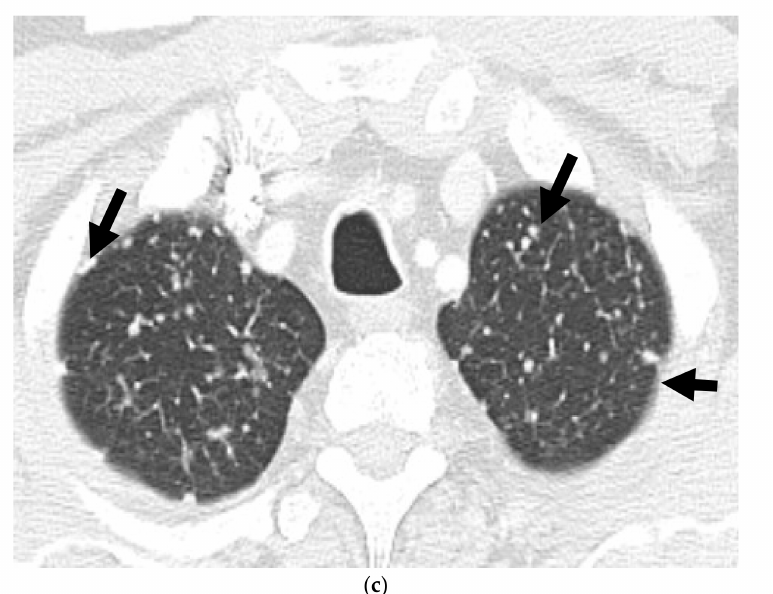
Figure 2. A 68-year-old man with palpable prostatic mass on rectal examination. Serum PSA was 0.3 ng/mL. Axial FDG-PET ( a ) and corresponding anatomic CT ( b ) of the PET-CT shows intensely hypermetabolic prostatic mass (long arrow) and pelvic bone metastases (short arrows). Axial lung window reformat of the CT chest ( c ) shows numerous small pulmonary nodules suspicious for metas- tases (arrows). Prostate biopsy showed high-grade carcinoma with neuroendocrine